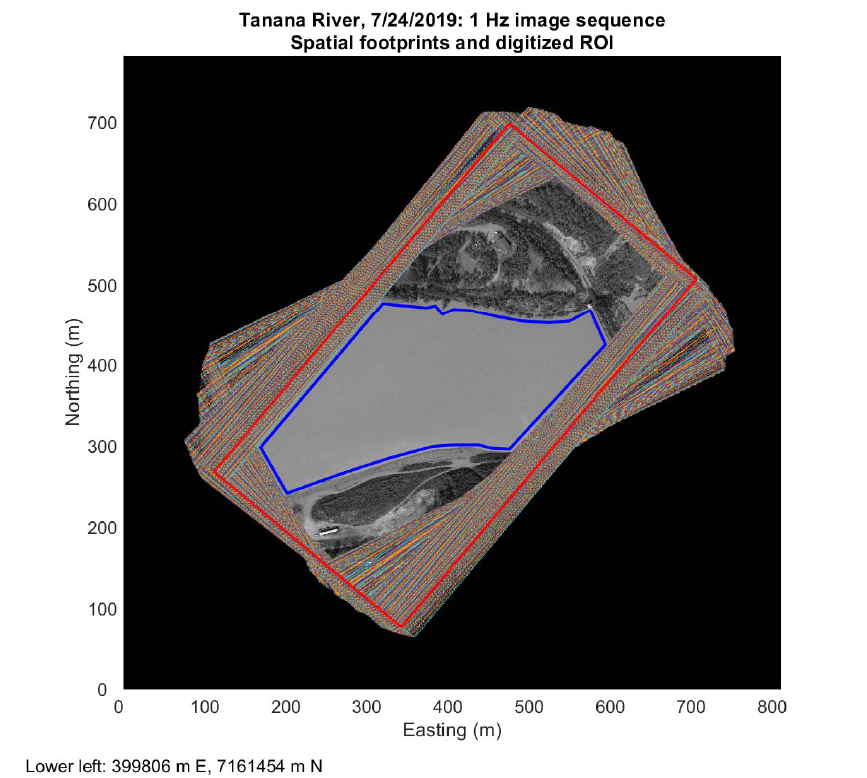
Figure 4. Actual spatial footprints of each image in the 1 Hz image sequence of the Tanana River are represented as rectangular polygons, with the footprint of the displayed image in red with a thicker line. The digitized region of interest (ROI) encompassing the water within the common area of coverage for the entire image sequence is represented by the blue